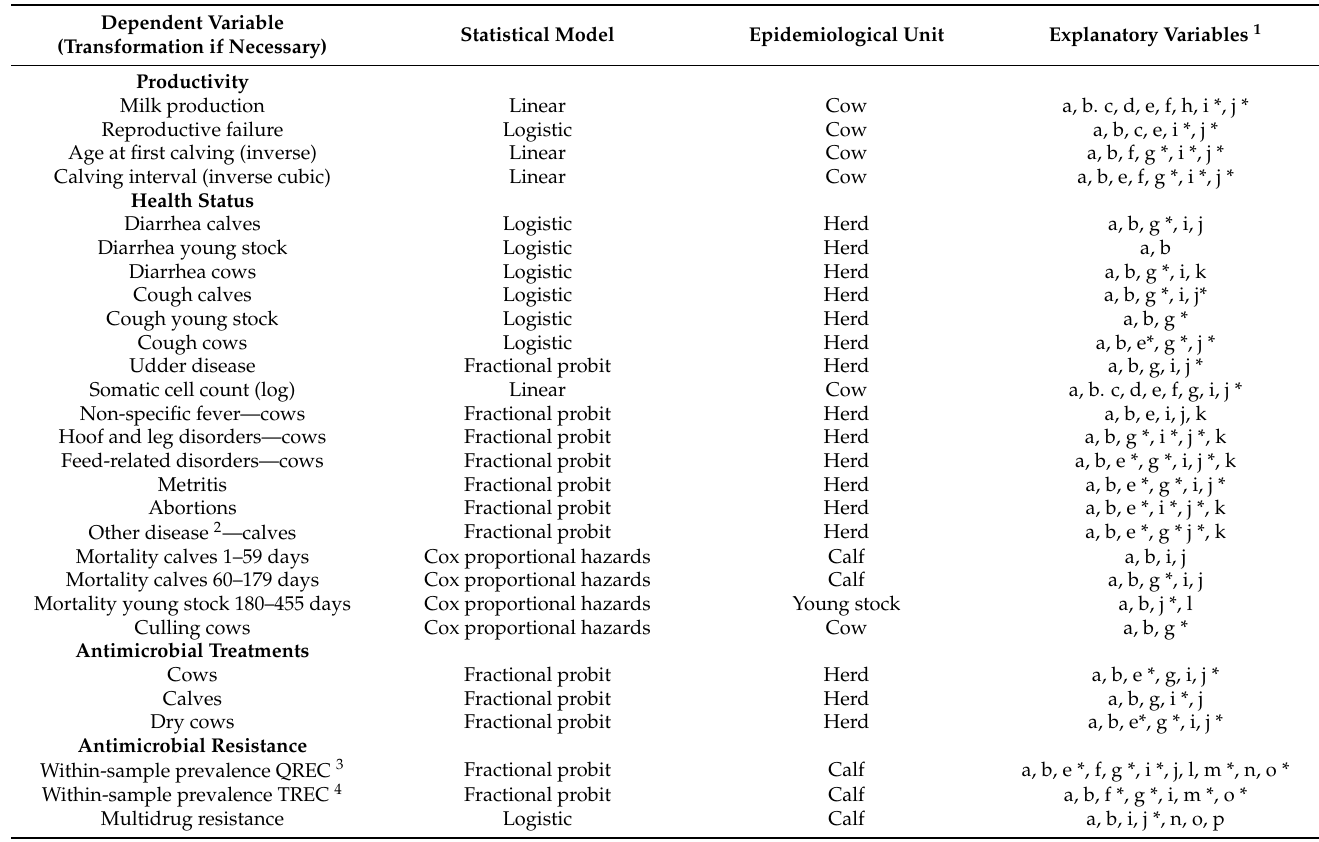
1 a = herd antibody status to bovine respiratory syncytial virus, b = herd antibody status to bovine coronavirus, c = parity, d = days in milk, e = breed, f = season, g = milk production, h = somatic cell count, i = herd size, j = geographic location, k = period, l = gender, m = calf age, n = calf use of antimicrobials, o = cow use of antimicrobials, p = sampling occasion, * Included as confounder. 2 Hoof or leg disorders, umbilical infections and dullness without obvious reason. 3 Quinolone-resistant Escherichia coli. 4 Tetracycline-resistant Escherichia coli